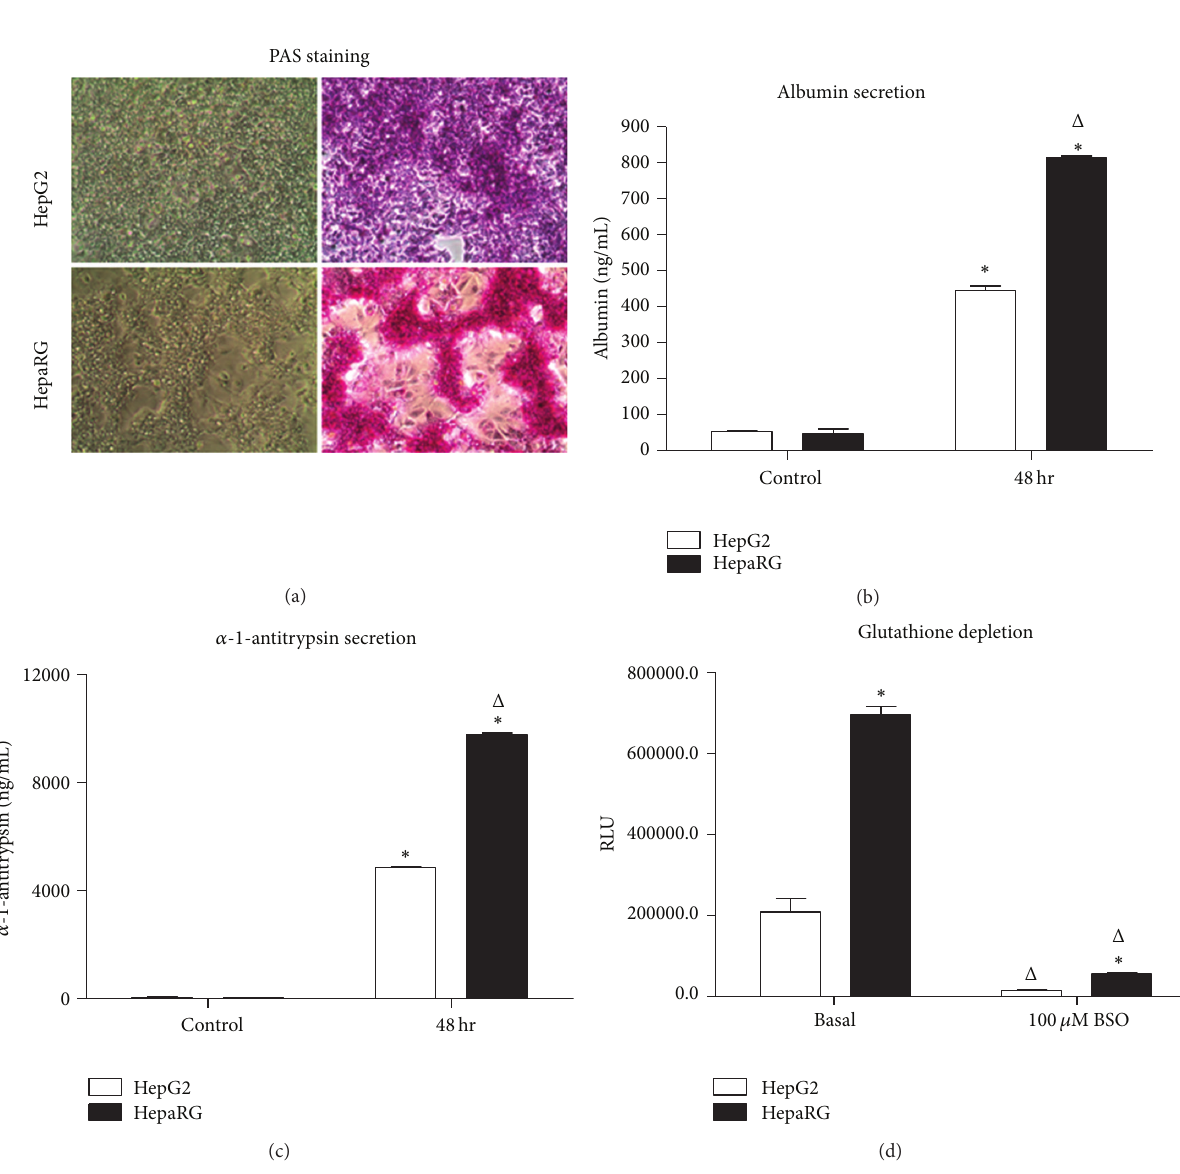
Figure 1: Expression of glycogen, albumin, alpha-1-antitrypsin, and glutathione in HepaRG and HepG2 cells seeded at 50,000 cells per well in 96-well plates and cultured for 48hrs following thaw. (a) Periodic Acid-Schiff staining for glycogen in HepG2 (upper panels) and HepaRG (lower panels). Unstained 10x phase contrast images are shown on the left side; 10x images of cells stained with PAS reagents are shown on the right side. (b) Secretion of albumin into tissue culture medium by HepaRG and HepG2 cells. Data represent mean ± SEM for 3 independent experiments. ∗ represents 𝑃 < 0.05 versus control measurements taken from culture media which had been unexposed to cells; Δ represents 𝑃 < 0.05 versus HepG2 cells. (c) Secretion of alpha-1-antitrypsin into tissue culture medium by HepaRG and HepG2 cells. Data represent mean ± SEM for 3 independent experiments. ∗ represents 𝑃 < 0.05 versus control measurements taken from culture media which had been unexposed to cells; Δ represents 𝑃 < 0.05 versus HepG2 cells. (d) Levels of glutathione in untreated cells and in HepaRG and HepG2 cells treated for 12 hrs with 100 𝜇 M buthionine sulfoximine (BSO). Data represent mean ± SEM for 3 independent experiments. ∗ represents 𝑃 < 0.05 versus HepG2 cells; Δ represents 𝑃 < 0.05 versus cells not treated with